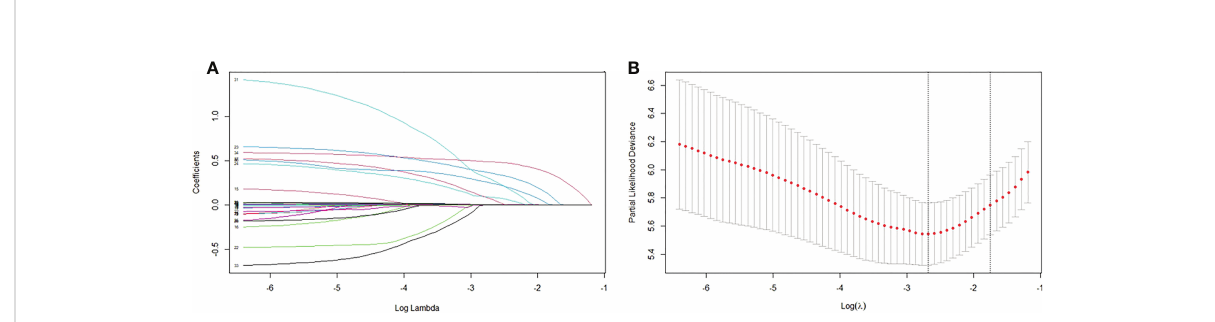
FIGURE 1 Factors associated with liver metastasis. (A) LASSO coef fi cient pro fi les of the 34 variables. (B) Optimum parameter (Lambda) selection in the LASSO model performed ten-fold cross-validation via minimum criteria.